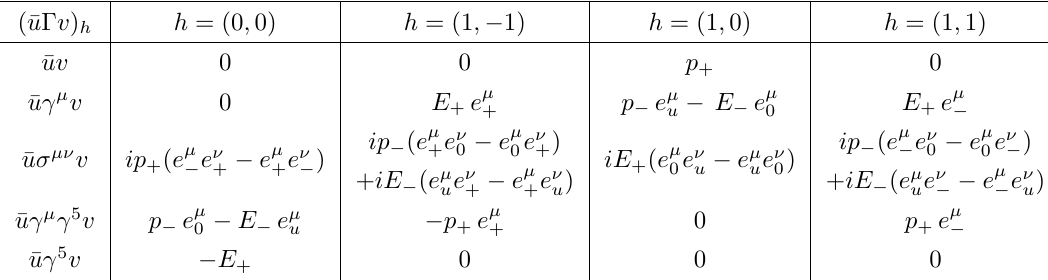
Table 8 . Decomposition of basis Dirac bilinears into helicity eigenstates of the two (cid:12)nal state fermions. For a de(cid:12)nition of the quantities appearing here, see eqs.